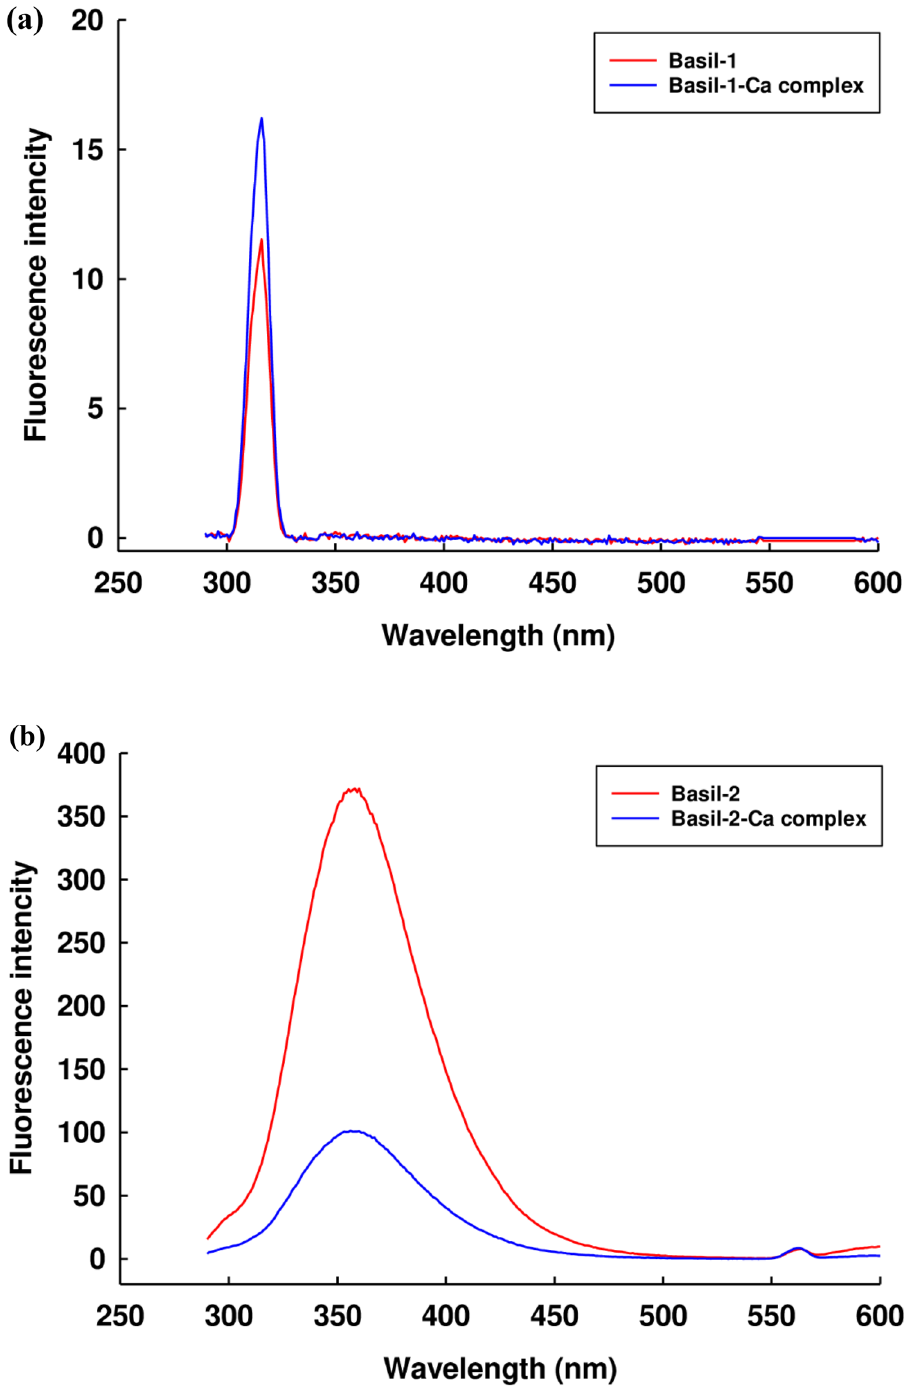
Figure 3. The fluorescence spectra of: ( a ) Basil-1 and the Basil-1-calcium complex; ( b ) Basil-2 and the Basil-2- calcium